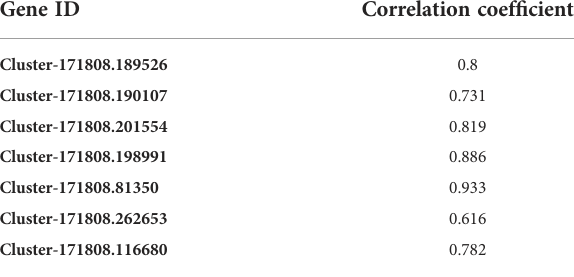
TABLE 3 Correlation coef fi cient between RNA-seq data and